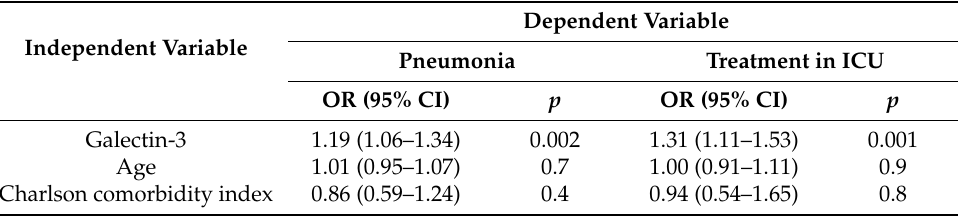
Table 6. Multiple logistic regression models showing the associations between galectin-3 and COVID-19 pneumonia and the need for intensive care. Odds ratios (OR) with 95% confidence intervals (95% CI) are reported per 1 unit increase in the value of each independent